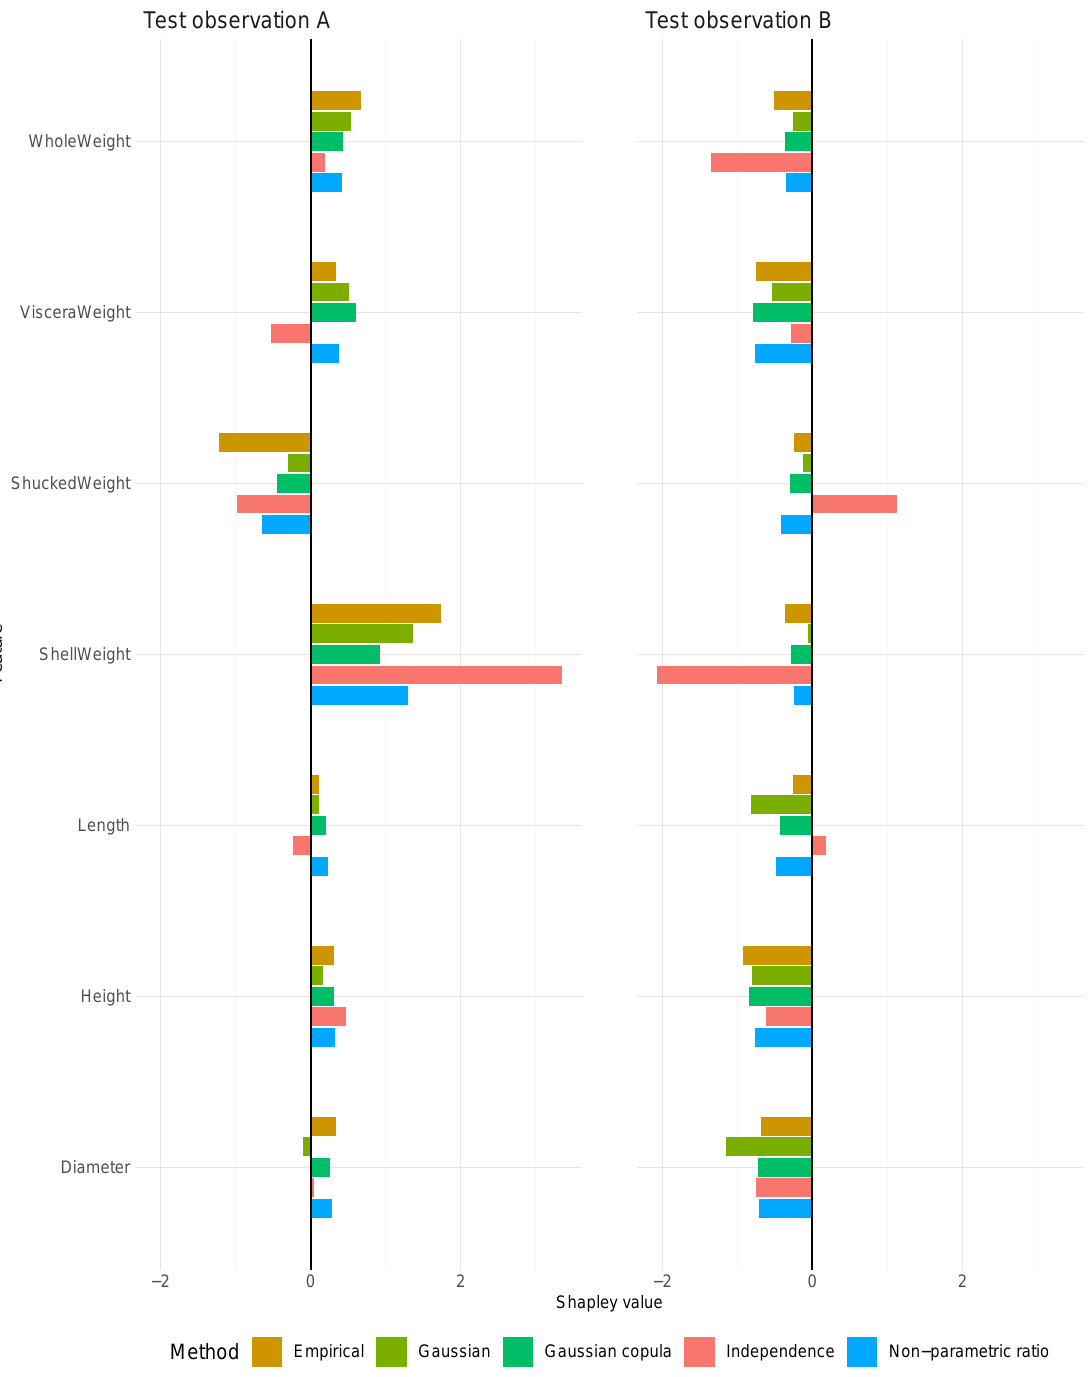
Figure 5: Shapley values for two of the test observations in the real data set computed using the different methods.